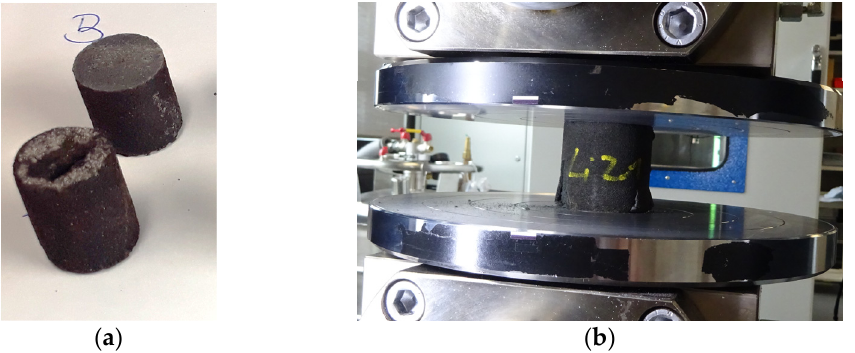
Figure 11. The 3D-printed specimens infiltrated with epoxy resin: ( a ) fully infiltrated specimens of dimensions D15 × 20 mm, ( b ) spalling effect during compression testing for specimens of dimen- sions D50 × 50 mm.